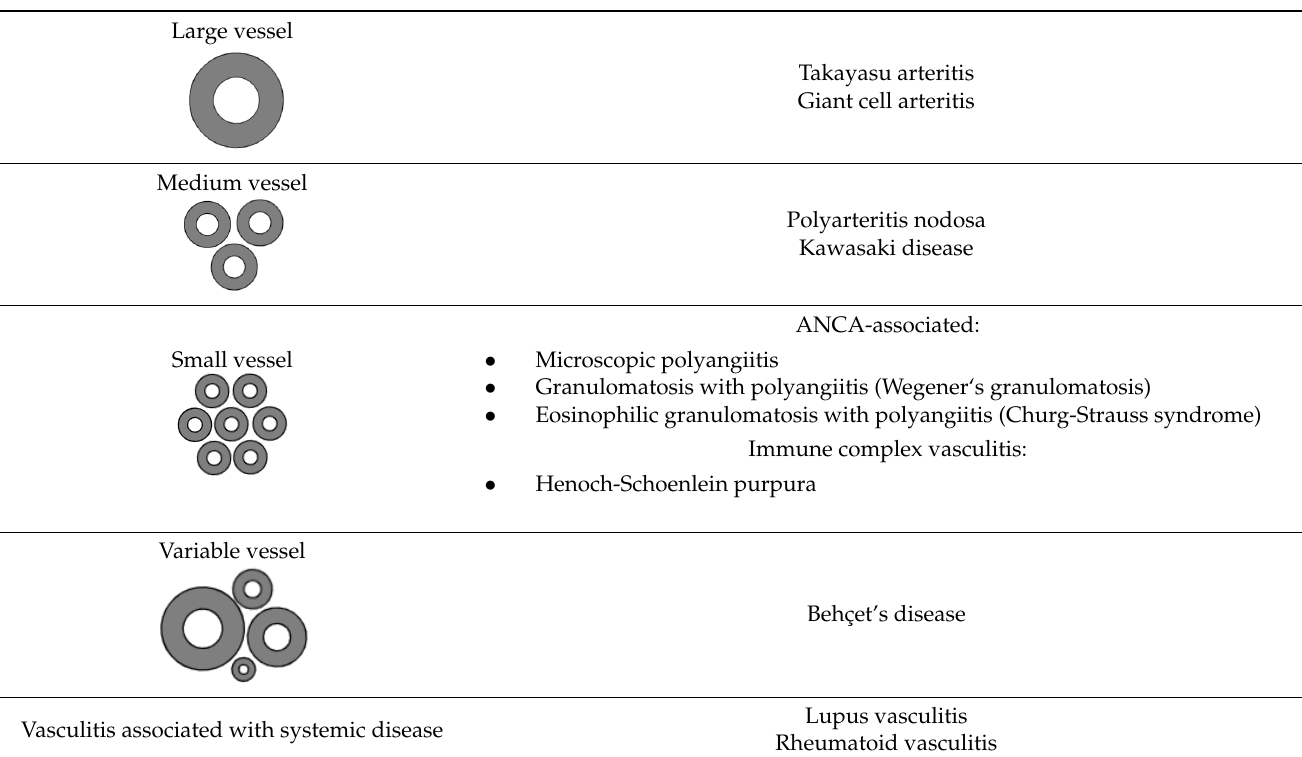
Table 1. Classification of the CNS vasculitides according to the affected vessel size and neurological manifestations.